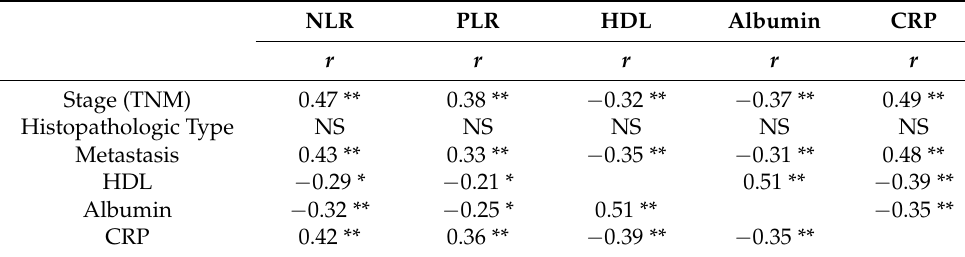
Table 3. Correlations between laboratory parameters and other parameters in lung cancer group.